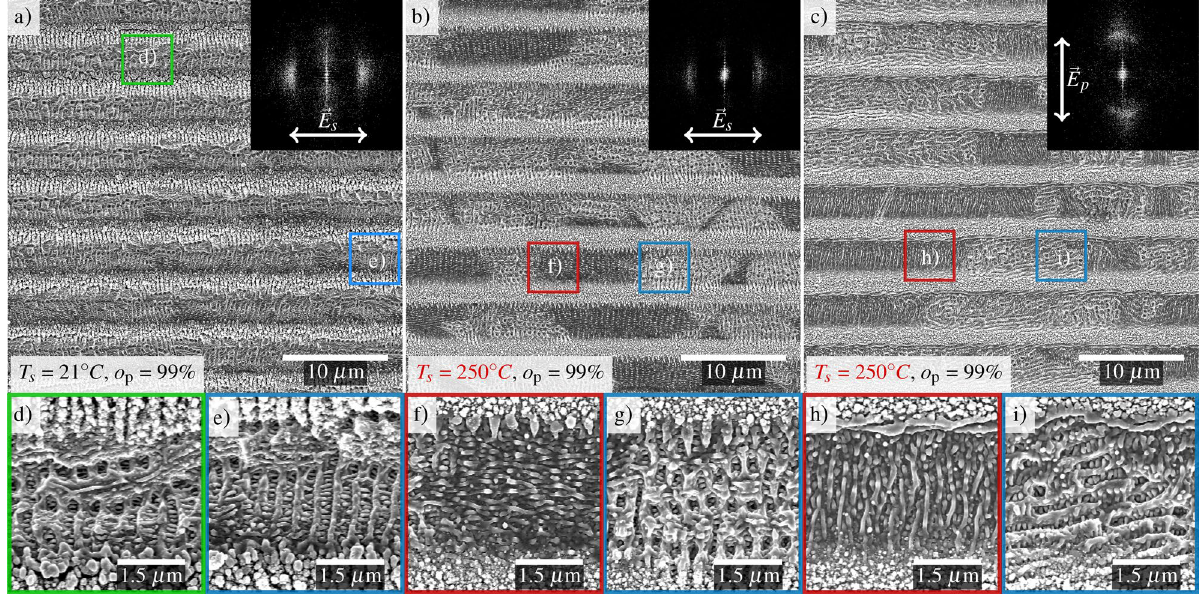
Figure 2. SEM images of the surface structures generated using DLIP. The process parameters were the same as those set in Fig. 1. The sample temperature T s , polarization, and pulse overlap o p are depicted in the images. The black insets show again the corresponding Fourier transforms. The images in ( d )–( i ) are enlargements of the marked areas in ( a )–( c ).